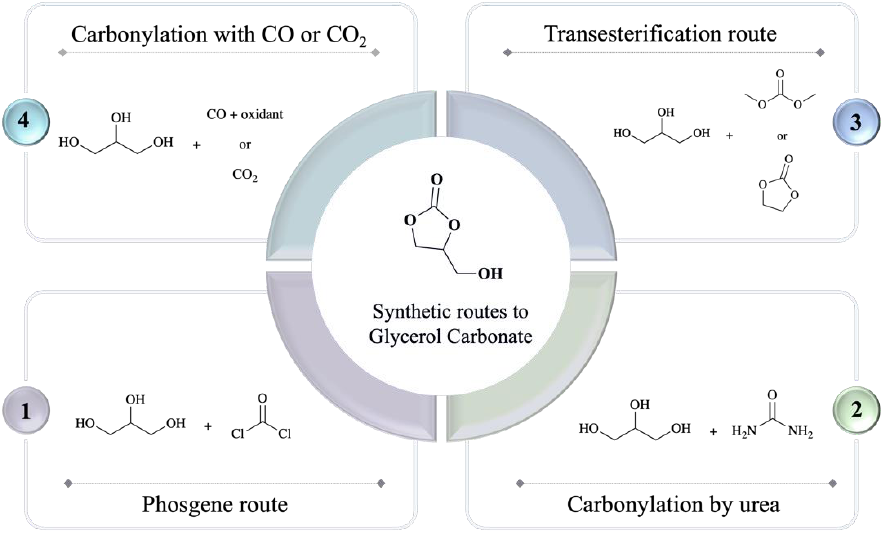
Figure 2. Main synthetic routes to glycerol carbonate.